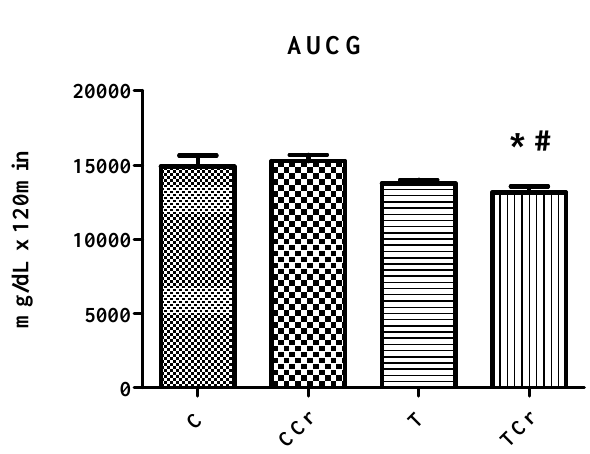
Figure 2. Area under the glucose curve during oral glucose tolerance test (OGTT) of the animals at the end of the experiment. The results are expressed as the mean ± SD of 10 animals per group. TCr = Trained Creatine; T = Trained; CCr = Control Creatine; C = Control not Trained. * different C; # different